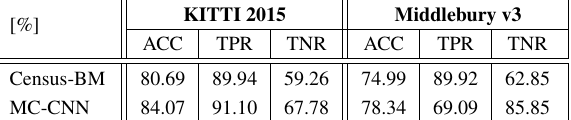
Table 3. Accuracy (ACC), true positive rate (TPR) and true negative rate (TNR) of the region mask predictions of the real-world applicable geometry-aware model. The TPR and TNR measure the proportions of pixels that are correctly assigned to the “good” and “hard” regions, respectively. For details on the evaluation procedure, please refer to Table 2.